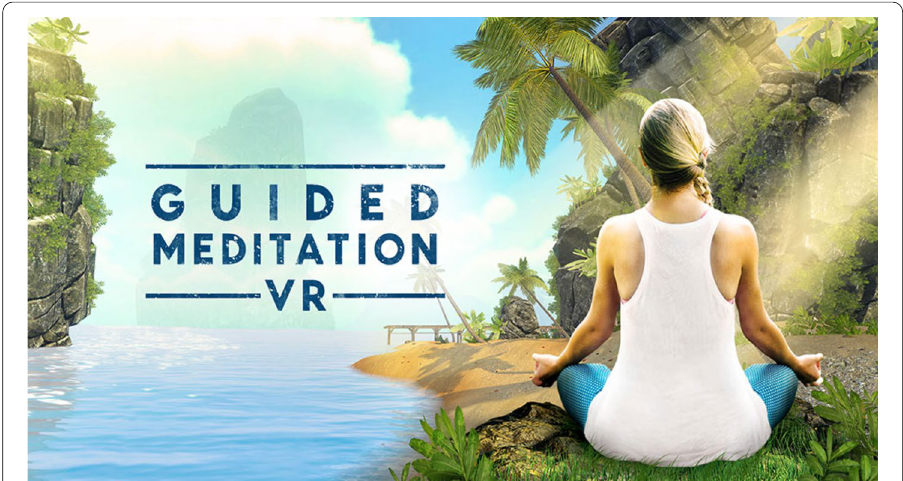
Fig. 2 Screenshot of Guided Meditation VR